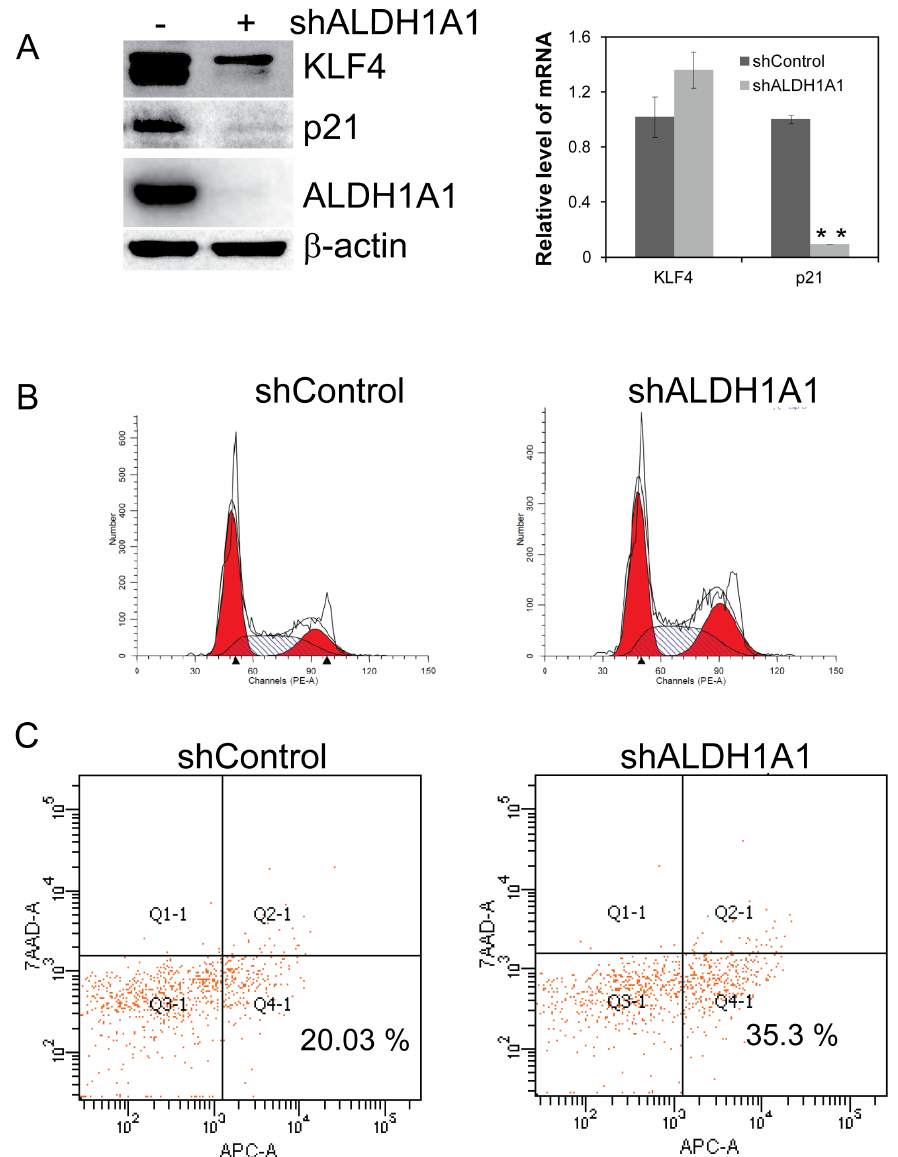
Figure 5. ALDH1A1 downregulation leads to lower KLF4 & p21 expression with altered cell-cycle profile. ALDH1A1 proficient and deficient A2780/CP70 cells were evaluated for expression of stem-like cell marker KLF4 and cell cycle checkpoint protein p21 by RT-PCR and Western blot analysis (A). Cell cycle distributions of cells were analyzed after fixing the cells in 70% methanol and propidium iodide staining followed by flow cytometry (B). Apoptotic cells were detected after staining the cells with APC-Annexin V and 7-AAD according to the manufacturer’s instructions and analyzed by flow cytometry (C).